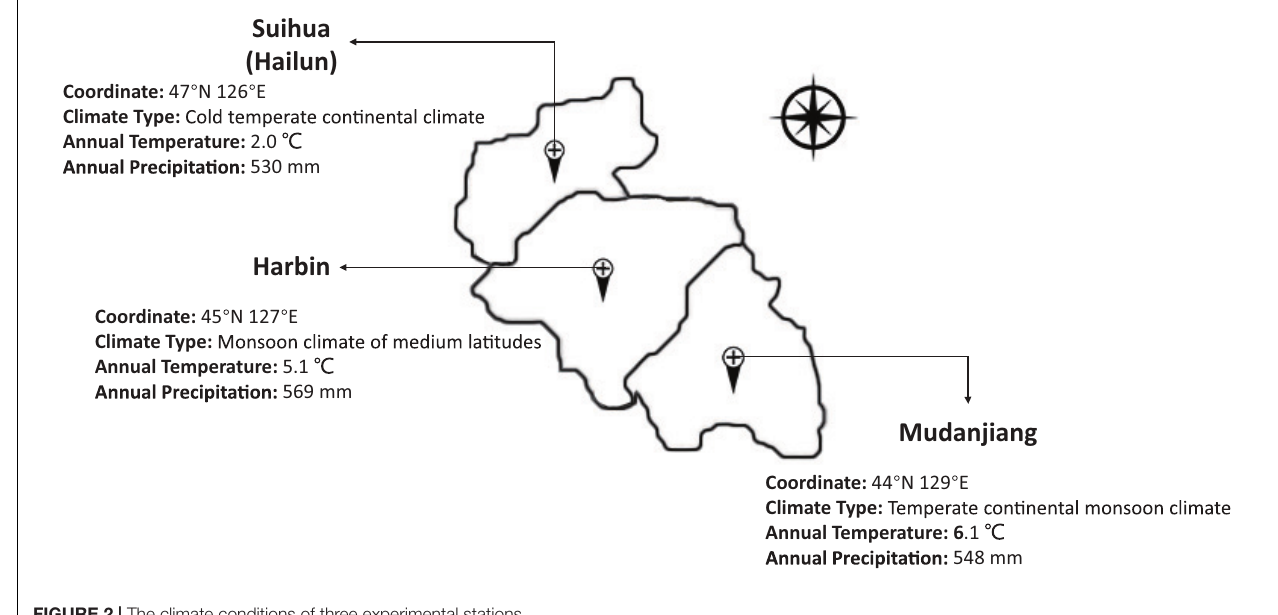
FIGURE 2 | The climate conditions of three experimental stations.